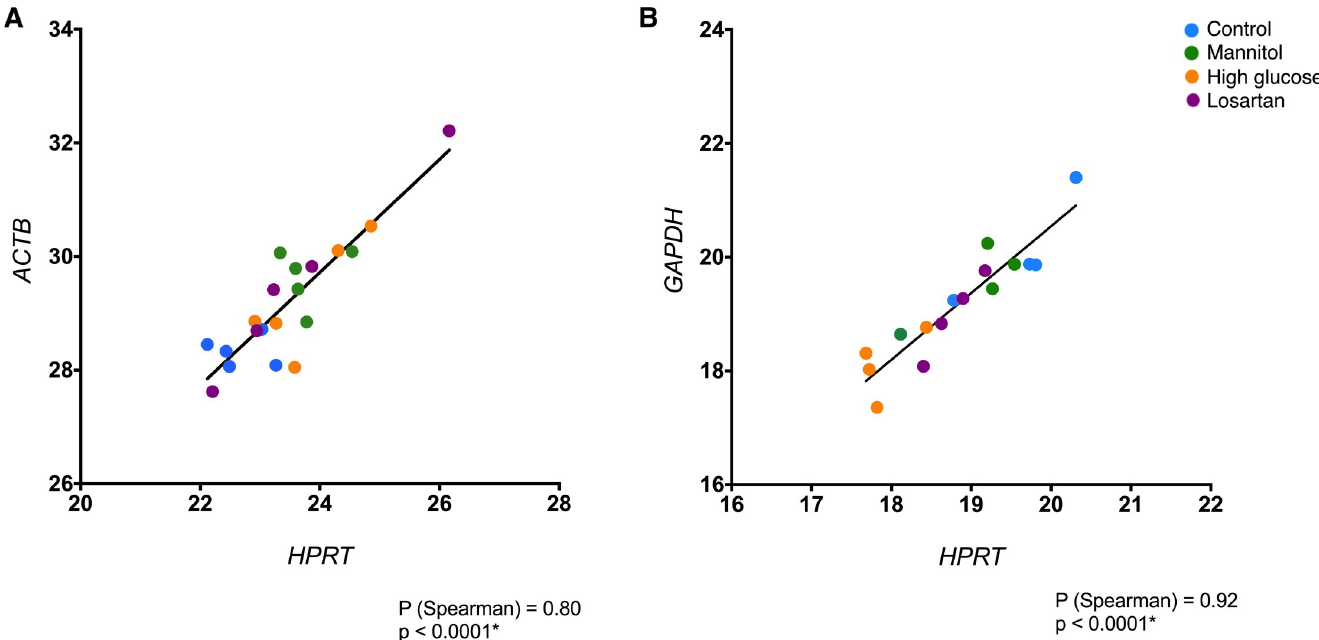
Fig 5. Correlation between top genes for both cell lines. Highly correlated genes are suitable for simultaneous use as reference genes. A) Correlation between ACTB and HPRT expression profile in mesangial cells. B) Correlation between GAPDH and HPRT expression profile in podocytes. ρ : Spearman’s rank correlation coefficient. � p <